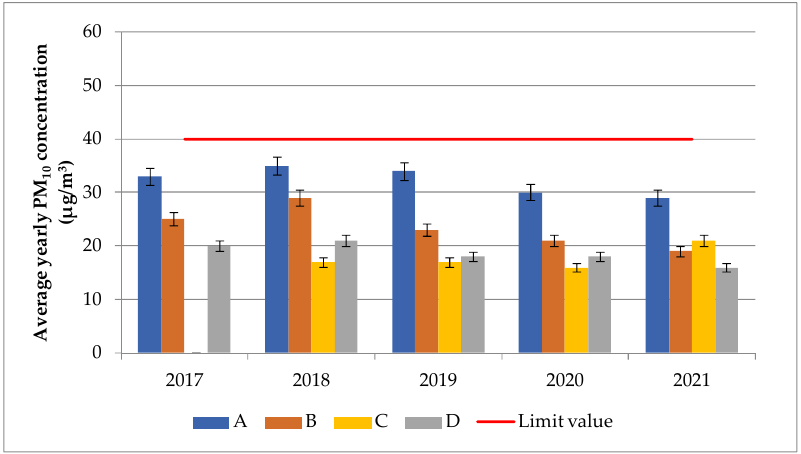
Figure 9. Average annual PM 10 concentrations at locations A, B, D, and E between 2017 and 2021. The PM 2 . 5 parameter was studied during the period from 2017 to 2021 at only two locations (A and D). The data availability was more than 70% at both locations. At other monitoring stations, the measurements of PM 2 . 5 were not established. The plots for daily average concentrations of PM 2 . 5 at these two locations during the study period are in the SM (Figure S4). Average, minimum, and maximum values with standard deviations are additionally included (SM, Table S4).